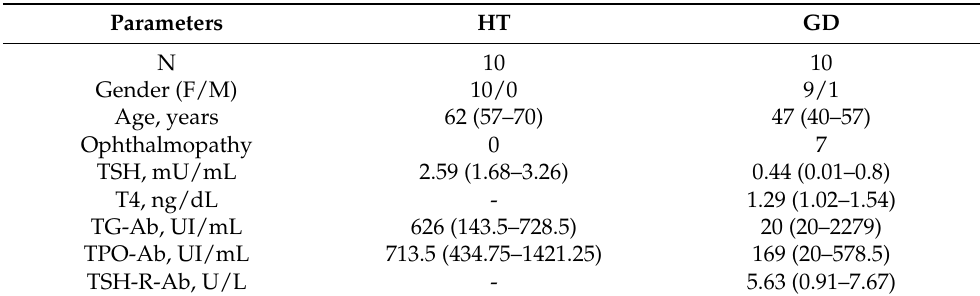
Table 1. Clinical parameters of AITD patients included in RT-qPCR analyses.